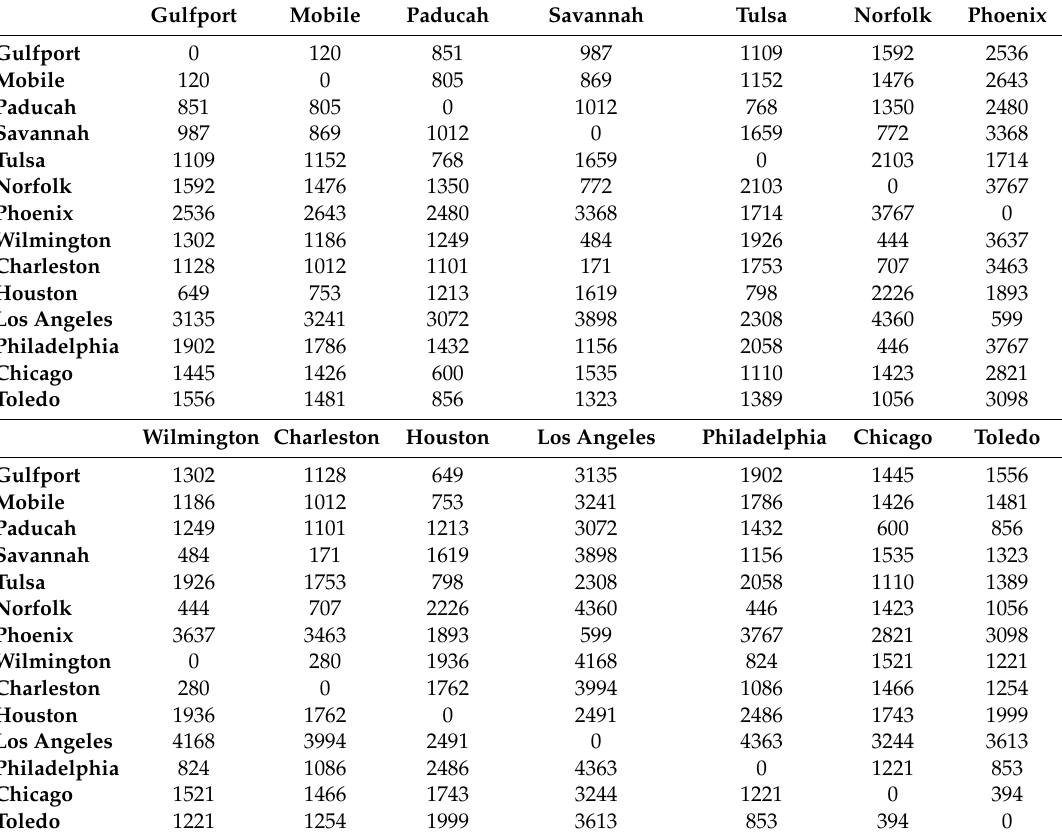
Table A4. Road distances between Extraction and Transesterification locations